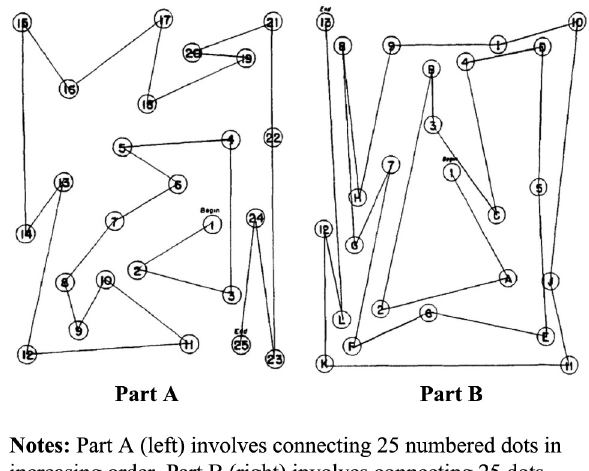
Figure 1. The TMT: Parts A and